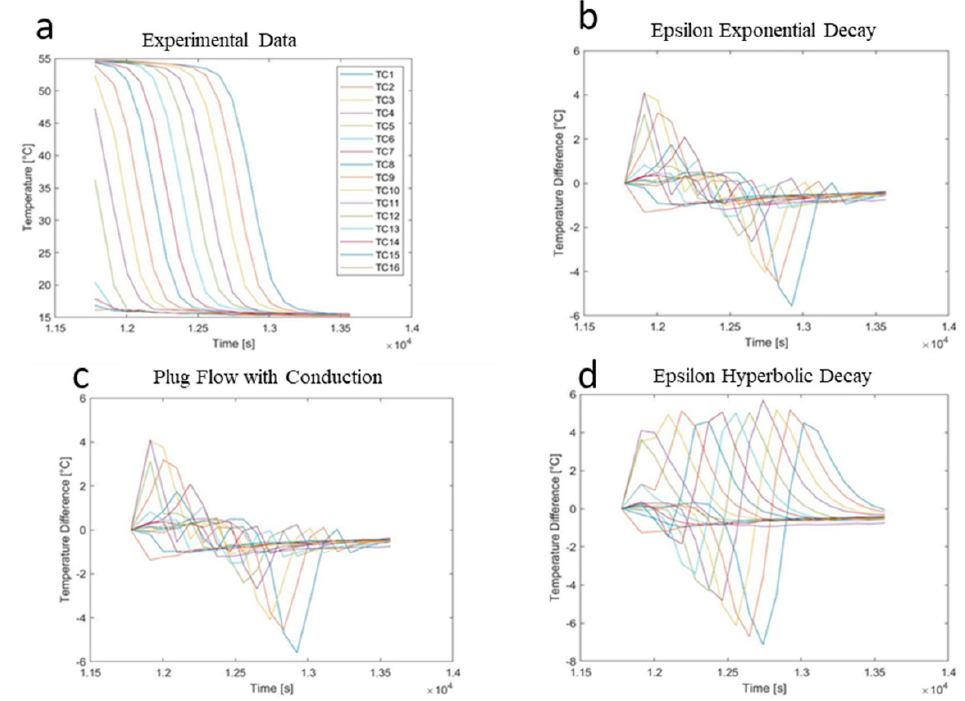
Figure 8. Discharge draws of 1.7 GPM for a cone diffuser without an antisiphon orifice temperature difference of experimental data subtracted from the model. ( a ) Experimental data; ( b ) ε model using exponential decay; ( c ) plug-flow model with the inclusion of conduction in the water; and ( d ) ε model using hyperbolic decay.